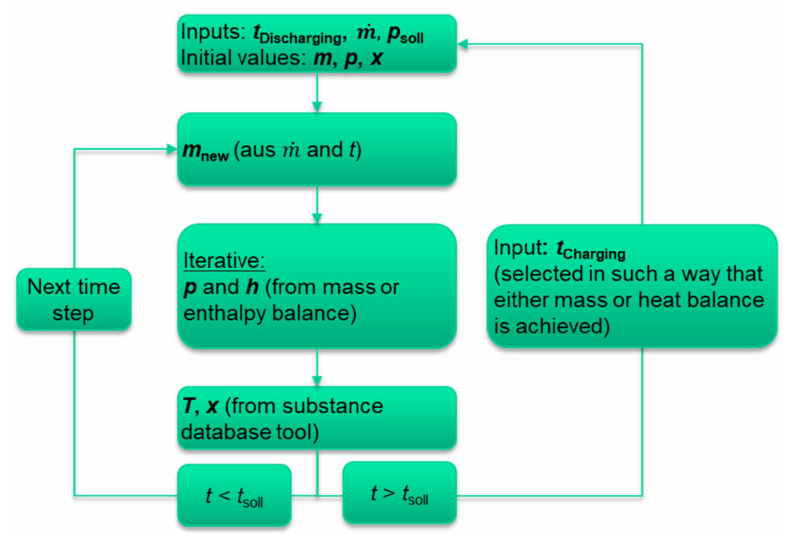
Figure 10. Iterative calculation scheme for the thermodynamic description of the storage state of a Ruths storage tank.